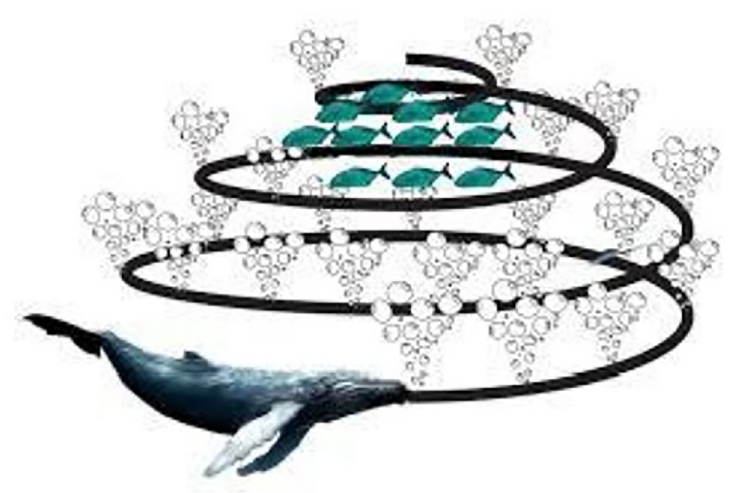
Fig 2. Humpback whales making bubble nets